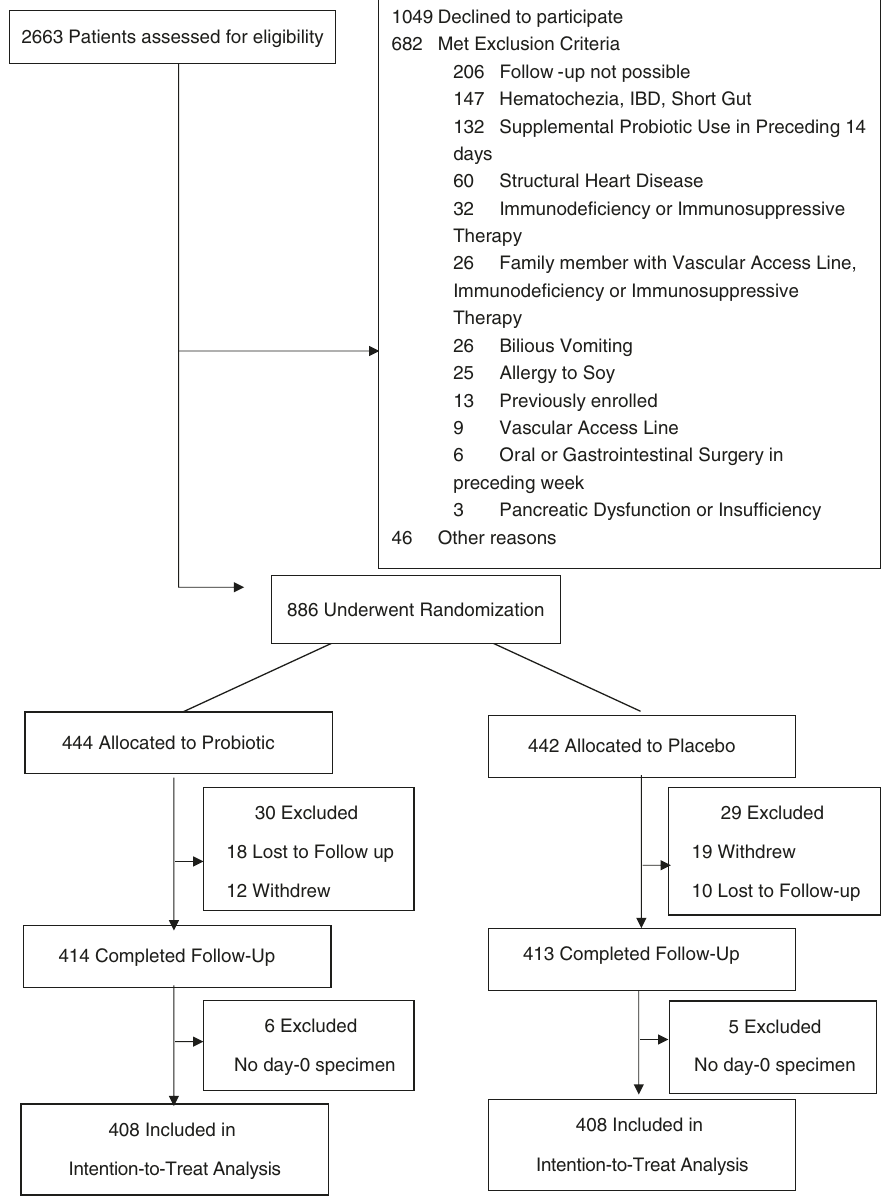
Fig. 1 Flow diagram of patient cohort. IBD in fl ammatory bowel disease; † Patients may have met more than one